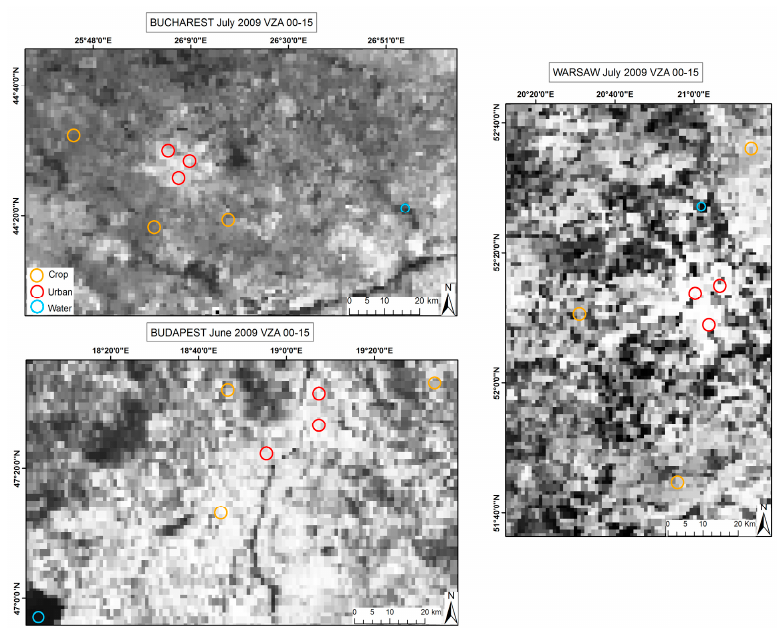
Figure 1. Image of Bucharest ( top ), Budapest ( bottom ), Warsaw ( right ) with samples of land cover classes: orange—croplands, red—urban, blue—water. Images are the July 2009 middle infrared radiance at a View Zenith Angle (VZA) class of 0°–15°. Table 1. Population and area of the three study cities.